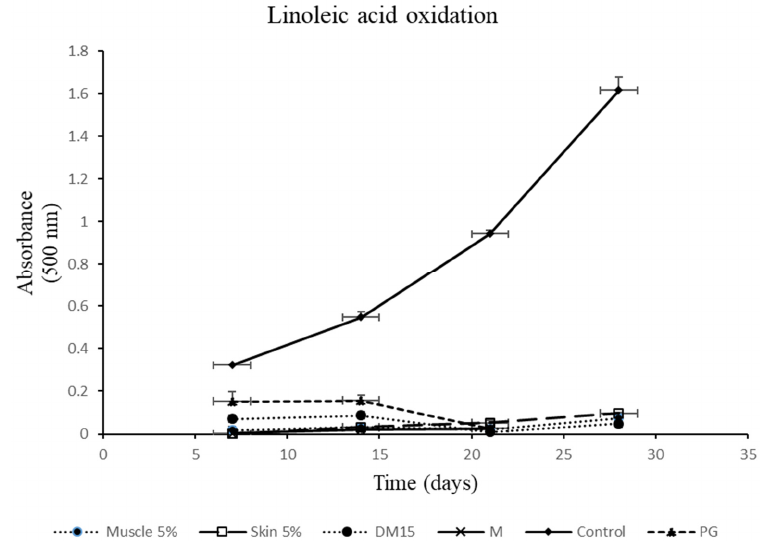
Figure 3. Evolution of the absorbance at 500 nm for the oxidation of linoleic acid, for 28 days of storage at 40 °C, in the presence of diet supplemented with 15 g/100 g of MO (15%), of samples of gilthead seabream (muscle and skin) fed with diet supplemented with 5 g/100 g of MO (5%) and of MO leaves, for four weeks, compared with a common food additive antioxidant, PG. All determi- nations were performed in triplicate and values shown are mean ± standard deviation. MO, Moringa oleifera; Level 1, M (MO leaves); Level 2, Muscle 0%, Muscle 5%, Muscle 10%, Muscle 15% (muscle